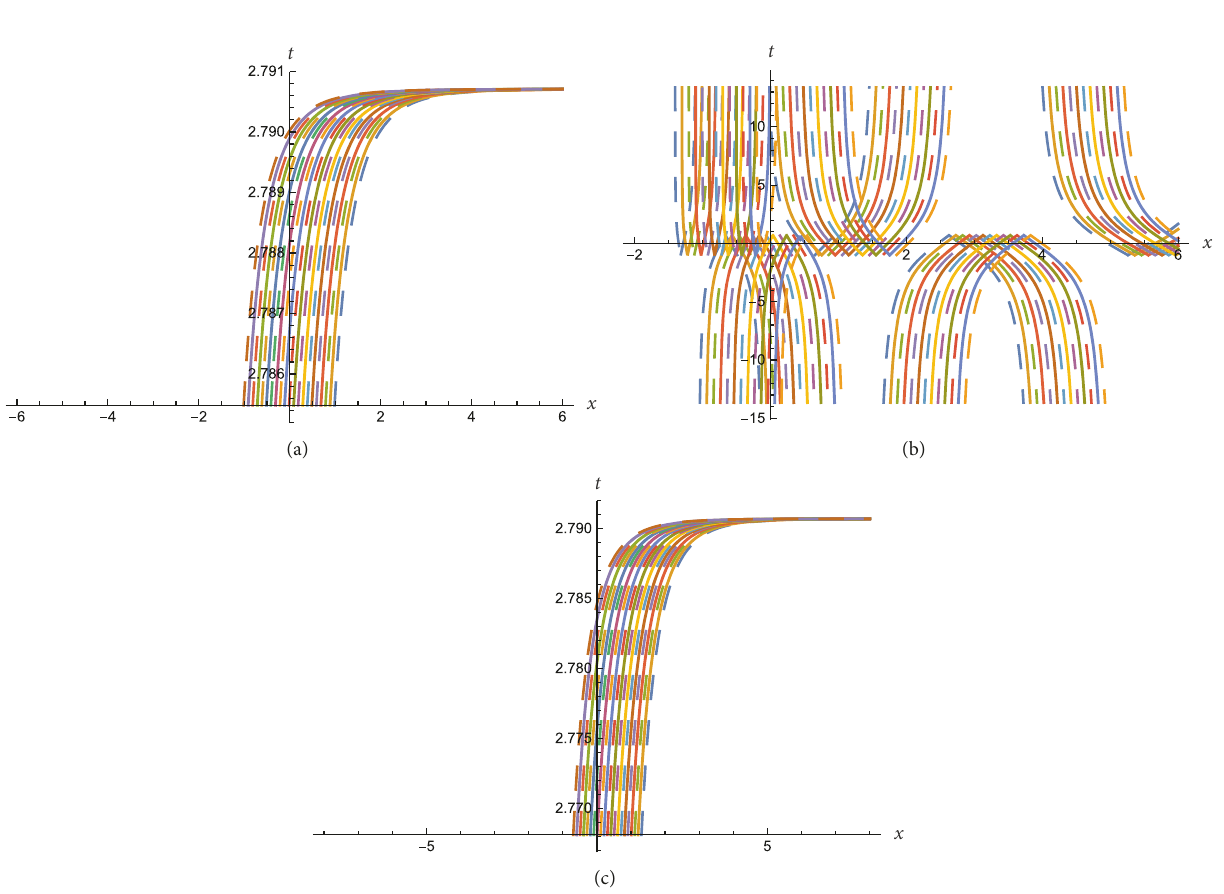
= 1; 𝛼 = 0.6;𝑙 = 0; 𝑙 = 9;𝑙 = −30; 𝜅 = −0.7; 𝑐 = 1 0 1 2 = 1;𝛼 = 0.6;𝑙 = 0.7; 𝑙 = 9;𝑙 = 20;𝜅 = 0.7;𝑐 = −0.1;𝑦 = 0.8 . 1 0 1 2